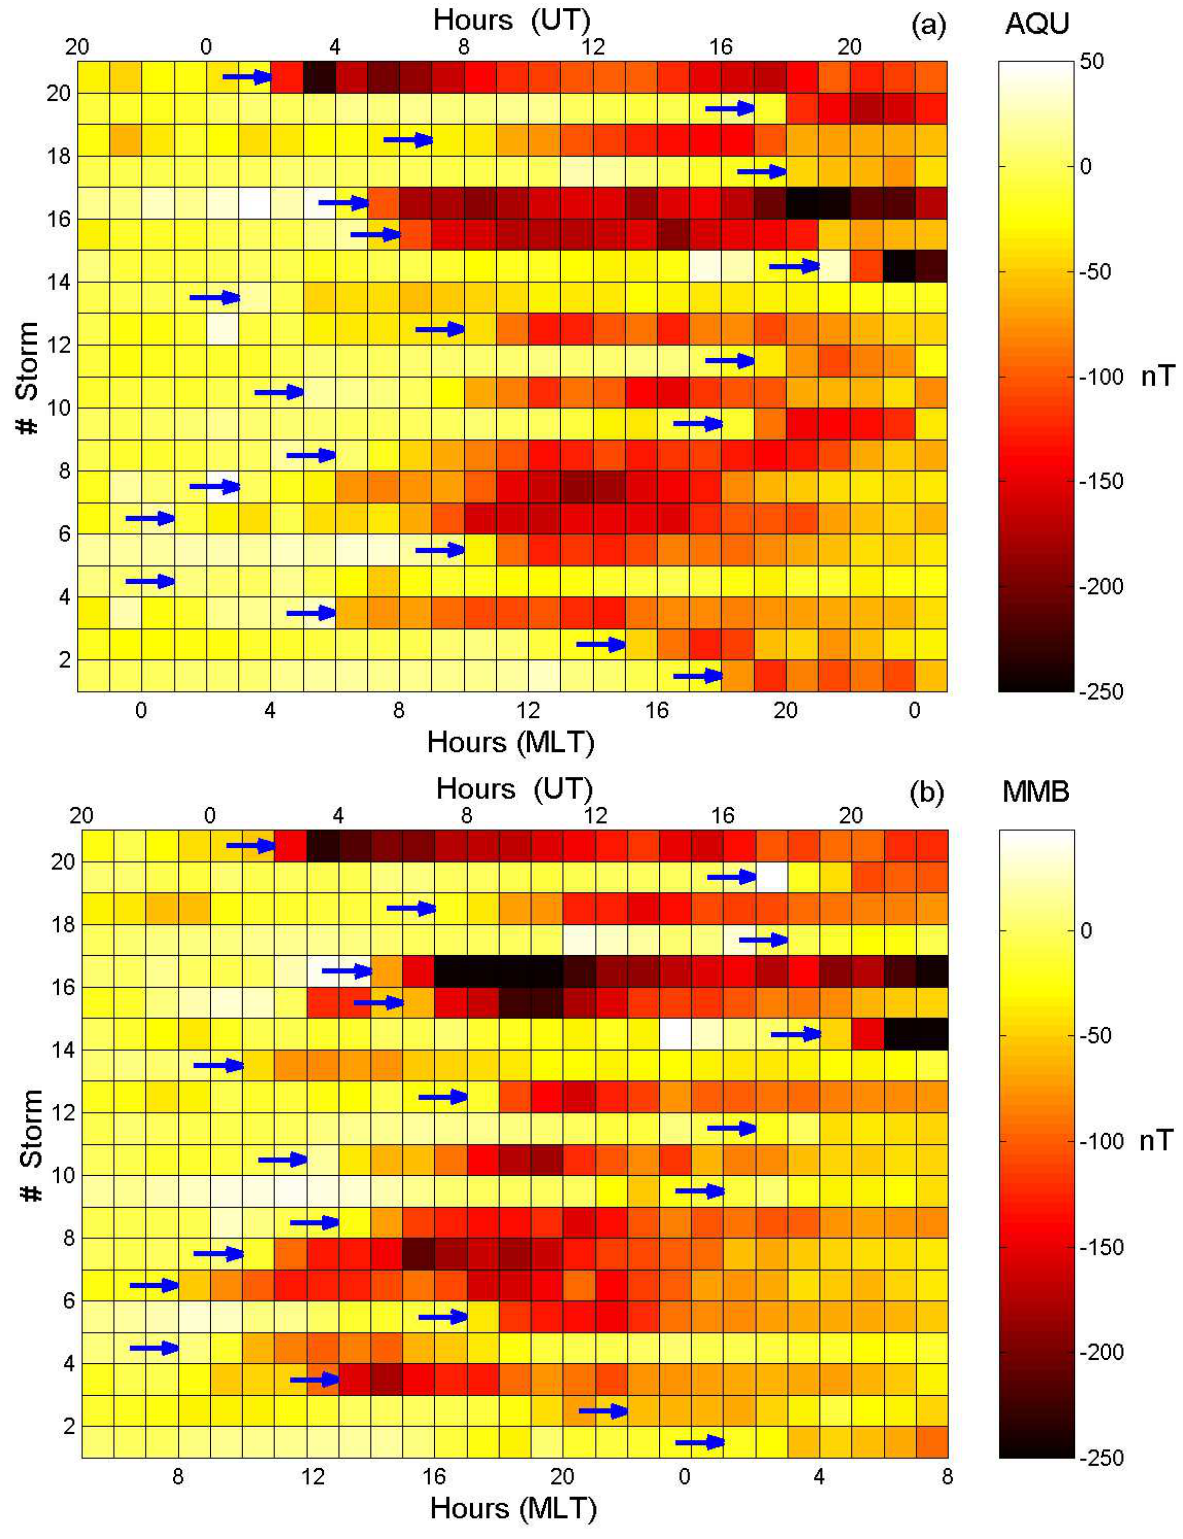
Fig. 1. The diurnal pattern of the H * hourly values at AQU ( a ) and MMB ( b ) for the selected events. Arrows mark the onset of each storm as observed from the D st